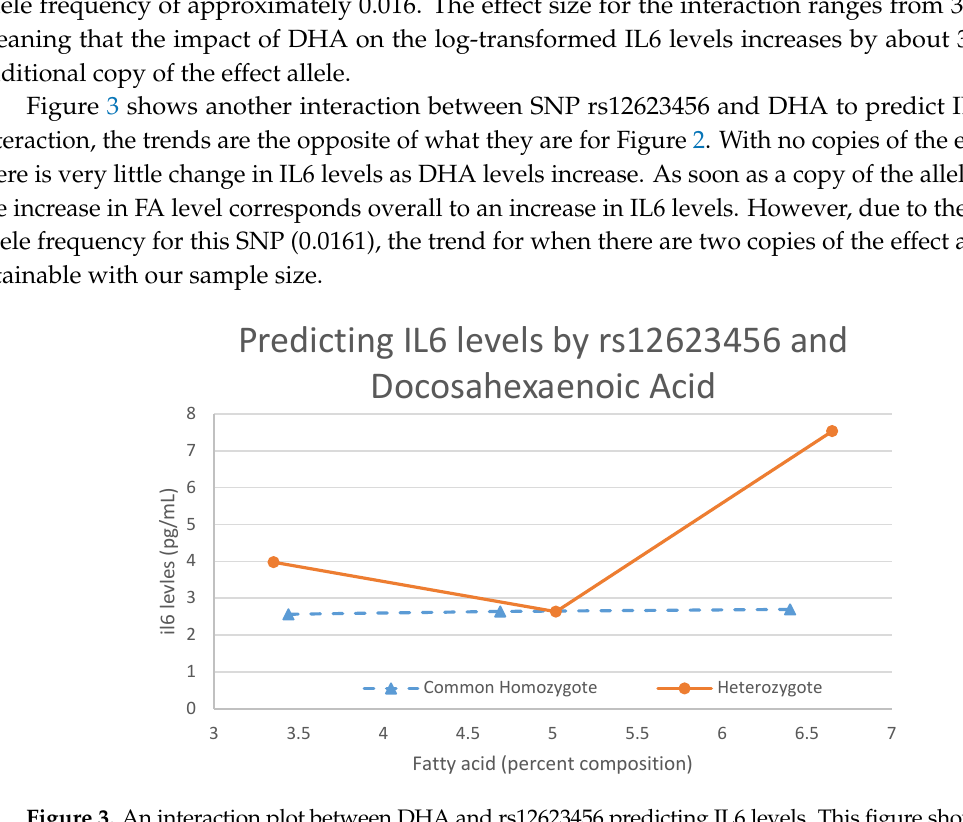
Figure 3. An interaction plot between DHA and rs12623456 predicting IL6 levels. This figure shows the modulating effects the genotype has on FAs and the effect that interaction has on biomarker levels. The rare homozygote is not included in this plot because, in our sample, there are no individuals with that